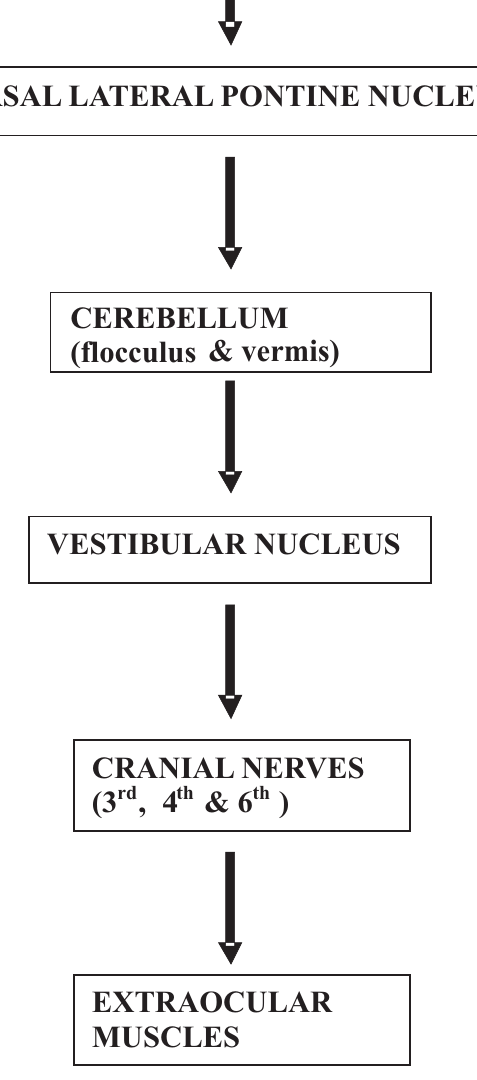
Figure 1: Overall neural control of pursuit eye